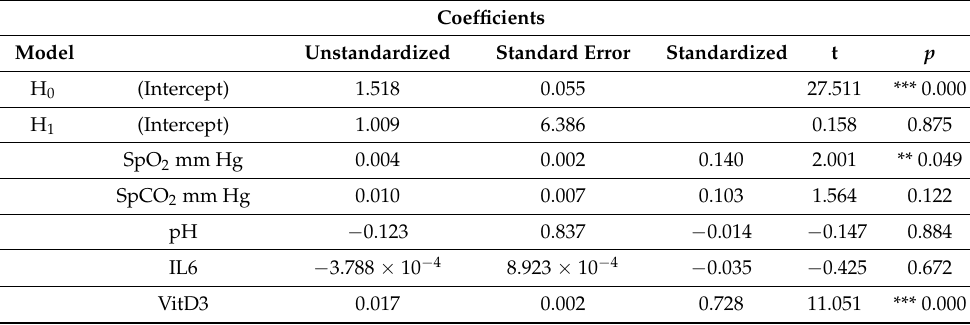
Table 8. Analysis of the